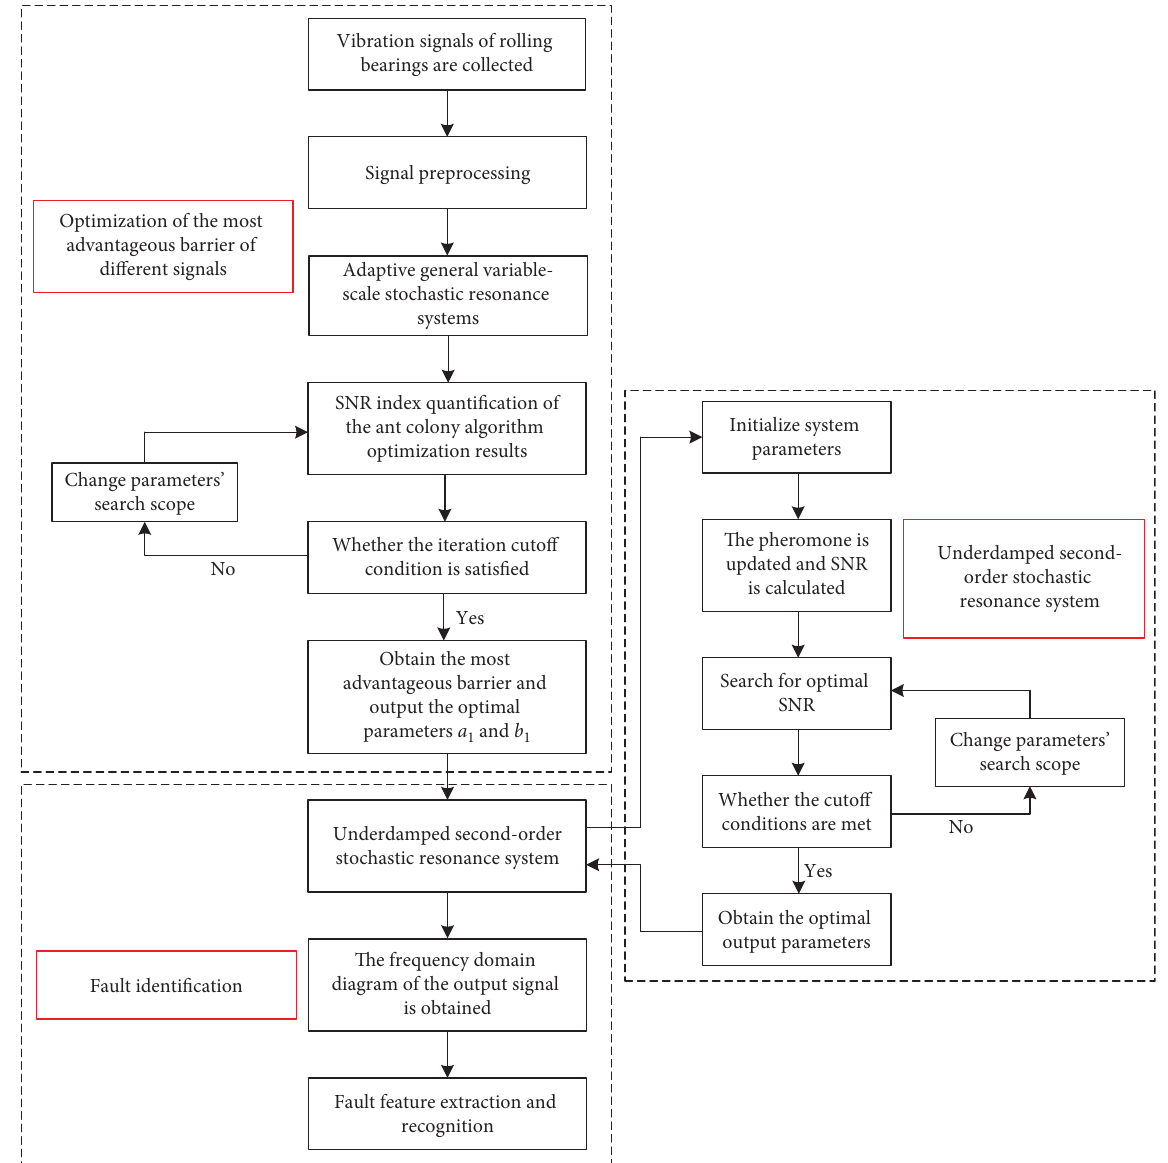
Figure 2: The USAGVSR method with potential well parameters’ optimization.